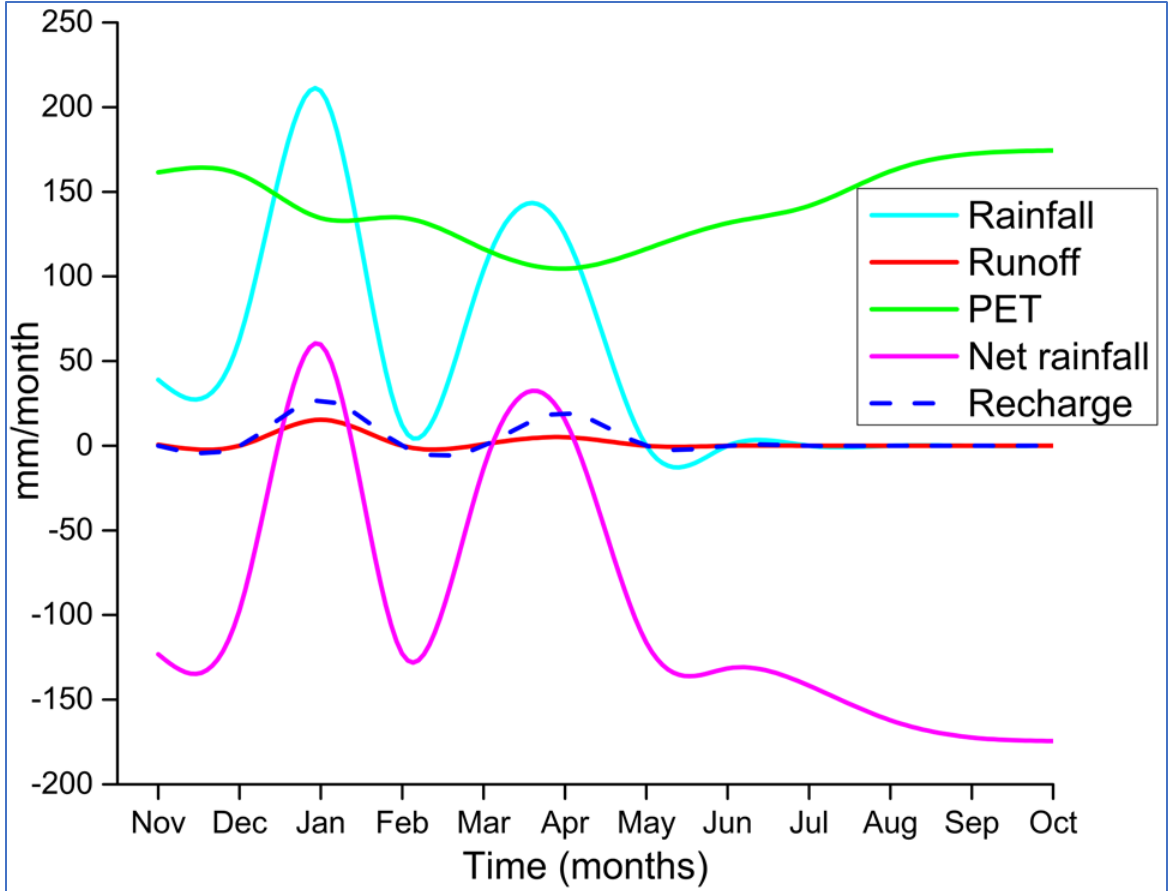
Figure 10. A 2017/2018 hydrological year graph of rainfall, runoff, PET, net rainfall, and aridity index in the Singida aquifer.